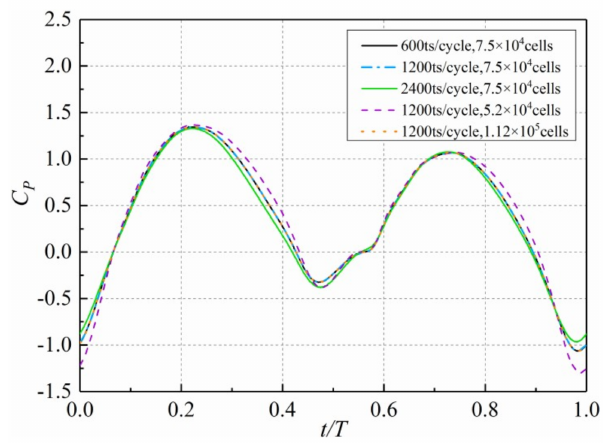
Figure 5. The variations of C P under different mesh strategies and time